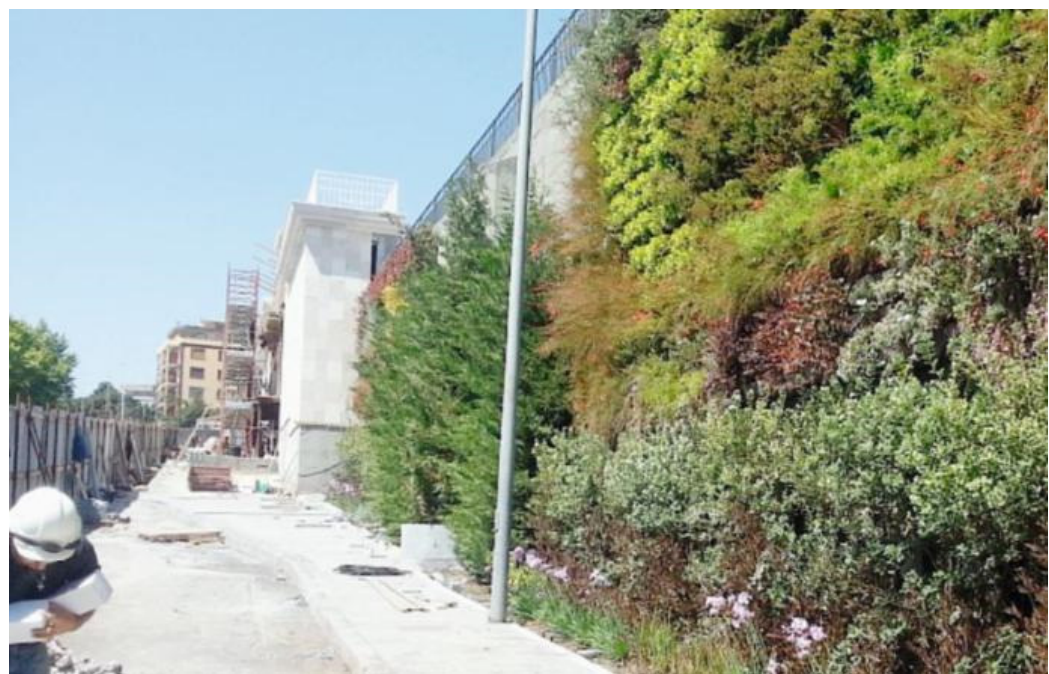
Figure 11. Tondo Gioeni (today, after the realization of the vertical wall).